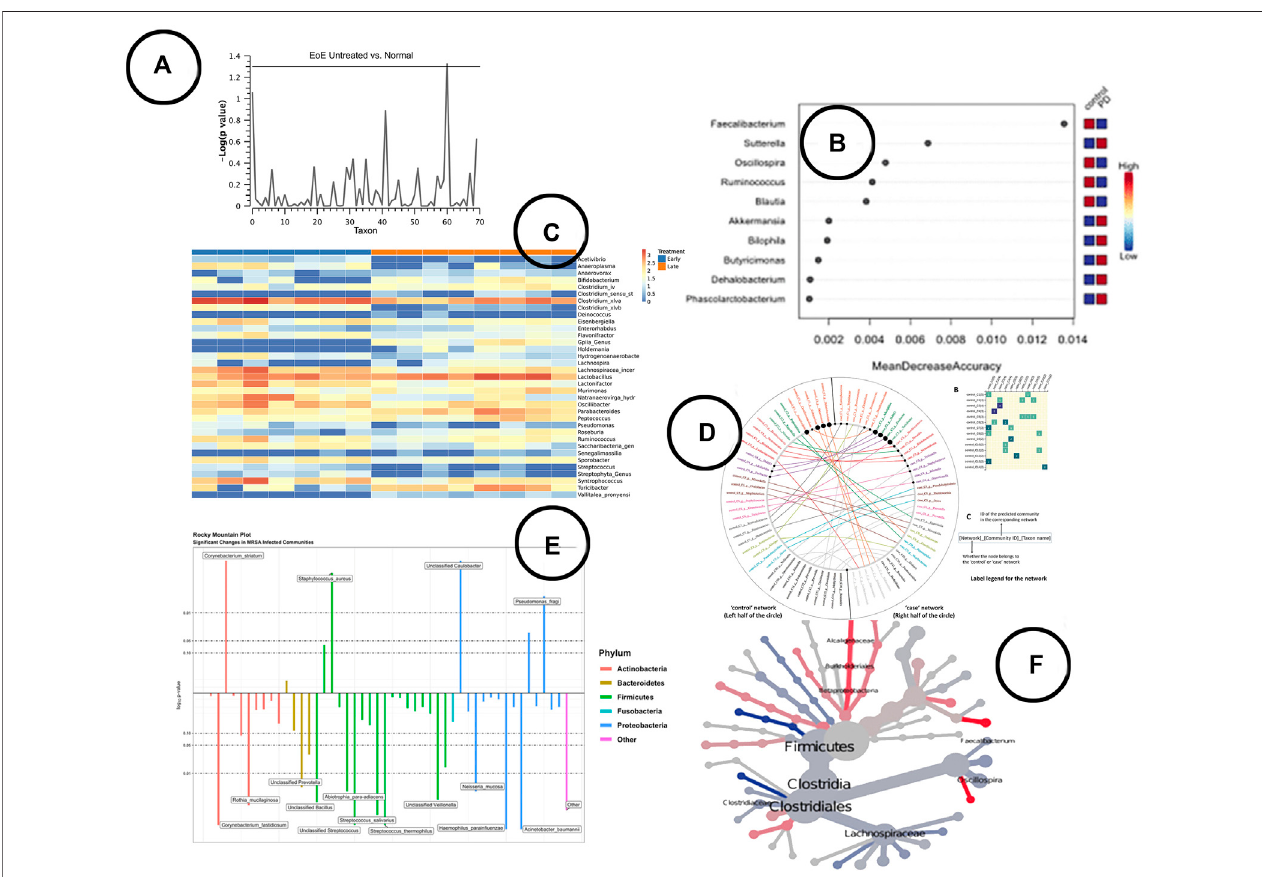
FIGURE 5 | An overview of the visual encodings used to display differential abundant taxa and identi fi ed biomarkers; (A) Manhattan plot showing statistically signi fi cant differential abundant taxa (Harris et al., 2015), (B) a visual presentation of the most signi fi cant taxa (potential biomarkers) (Cosma-Grigorov et al., 2020), (C) differenceinabundanceofsigni fi canttaxashowninaheatmapinBiomMiner(Shamsaddinietal.,2020),( D ) “ communityshuf fl ingplot ” showingthechangesinmicrobial interactions between clinical groups in Netshift (Kuntal et al., 2019a), (E) rocky mountain plot indicating differential abundant taxa in tidyMicro (Carpenter et al., 2021), (F) a heat tree visualization showing signi fi cantly different taxa between disease and control group (Cosma-Grigorov et al.,